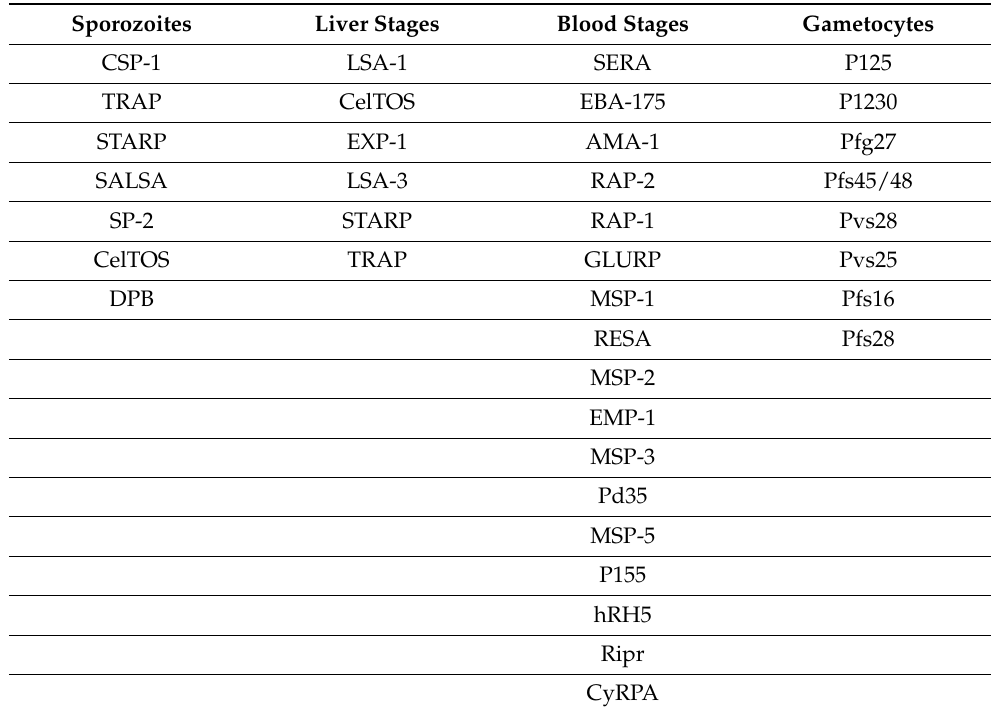
Table 4. Plasmodium antigens that have been explored as vaccines/antigens, by parasitic stage Adapted with permission from ref. [87] Copyright 2007 Bentham Science Publishers and [88] Copy- right 2016 Intech OpenAbbreviations: CSP, circumsporozoite protein; TRAP, thrombospondin-related adhesive protein; ME-TRAP, multiple epitope-thrombospondin-related adhesive protein; STARP, sporozoite threonine- and asparagine-rich protein; SALSA, sporozoite- and liver-stage antigen; SSP, sporozoite surface protein; SPf66, synthetic P. falciparum 66; MSP, merozoite surface protein; RESA, ring-infected erythrocyte surface antigen; GLURP, glutamine-rich protein; AMA, apical membrane antigen; SERA, serine-repeat antigen; EBA, erythrocyte-binding antigen; HRH5 reticulocyte-binding protein homologue 5, EMP, erythrocyte membrane protein; RAP, rhoptry-associated protein; LSA-1/3, Liver-stage antigen-1/3; CelTOS, Cell-traversal protein for ookinetes and sporozoites; DBP, Duffy binding protein, EXP-1, Exported protein-1; Ripr, RH5-interacting protein; CyPRA, Cysteine-rich protective antigen; Pf, Plasmodium falciparum protein; Pv, Plasmodium vivax